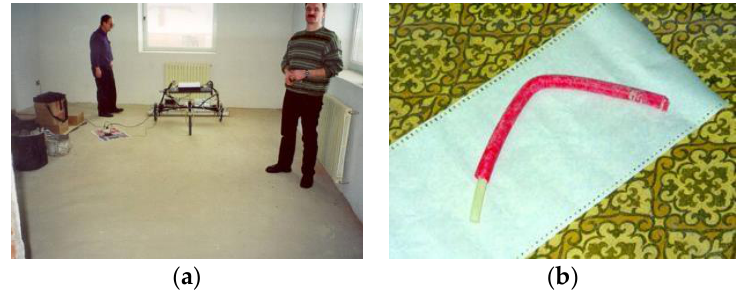
Figure 22. ( a ) MiRascan radar at work and ( b ) sample of plastic